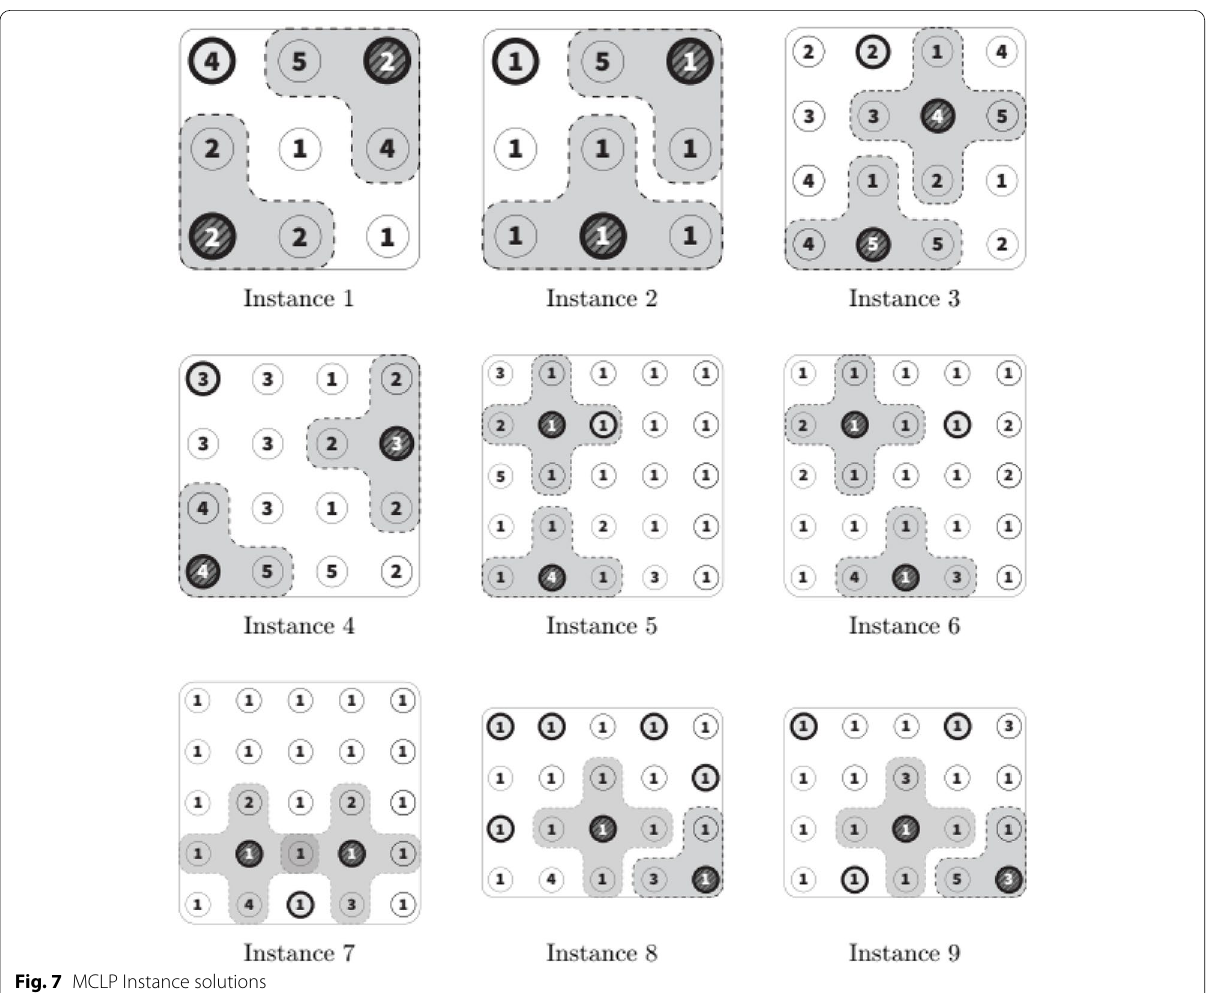
Fig. 7 MCLP Instance solutions